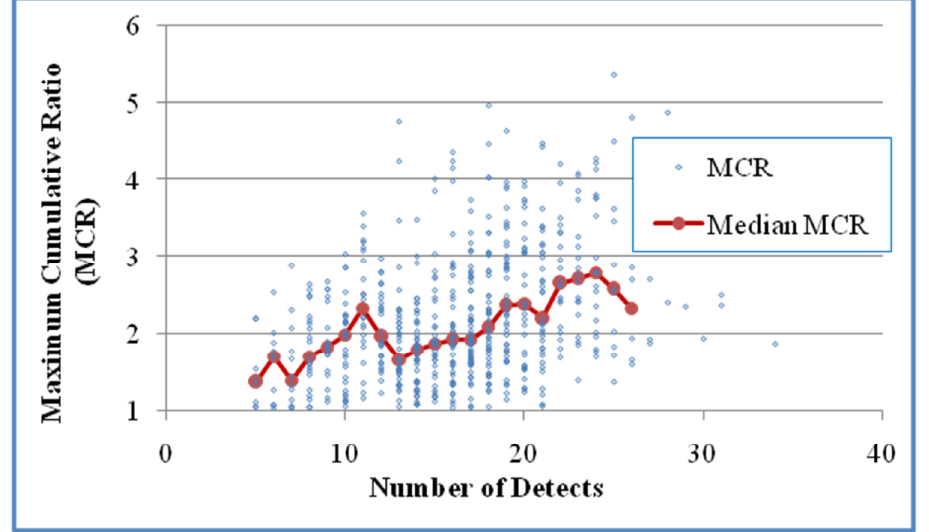
Figure 5. The relationship between MCR and the number of detects in the samples for Case 1 (618 mixtures). A positive correlation was shown either based on all mixtures (Kendall’s τ = 0.2511 and p < 0.0001) or median MCR of grouped mixtures for groups with at least five values (τ = 0.6826 and p < 0.0001).